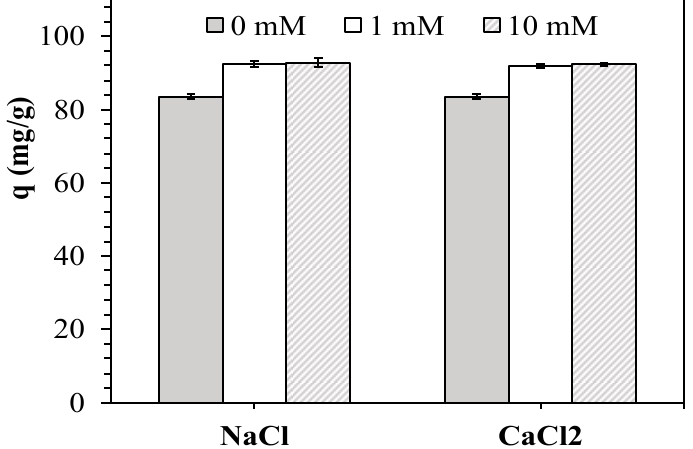
Figure 8. E ff ect of coexisting cations on Cu(II) adsorption. Here, q denotes the adsorption